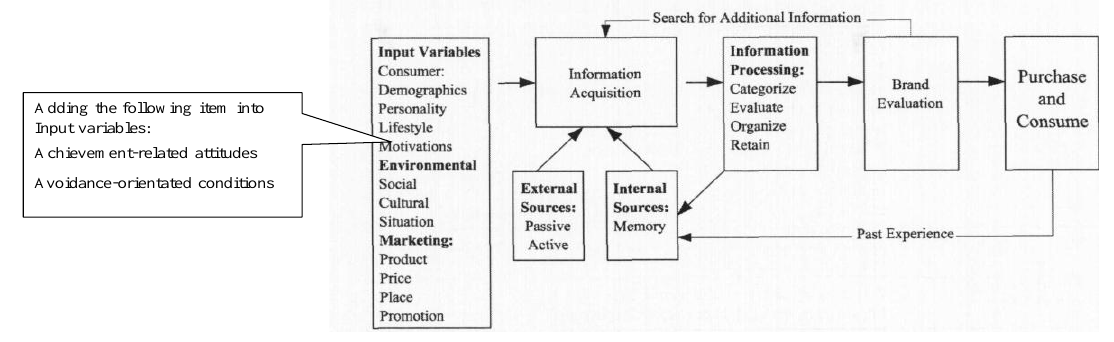
Figure 7. Modified Assael’s Consumer Information Acquisition and Processing